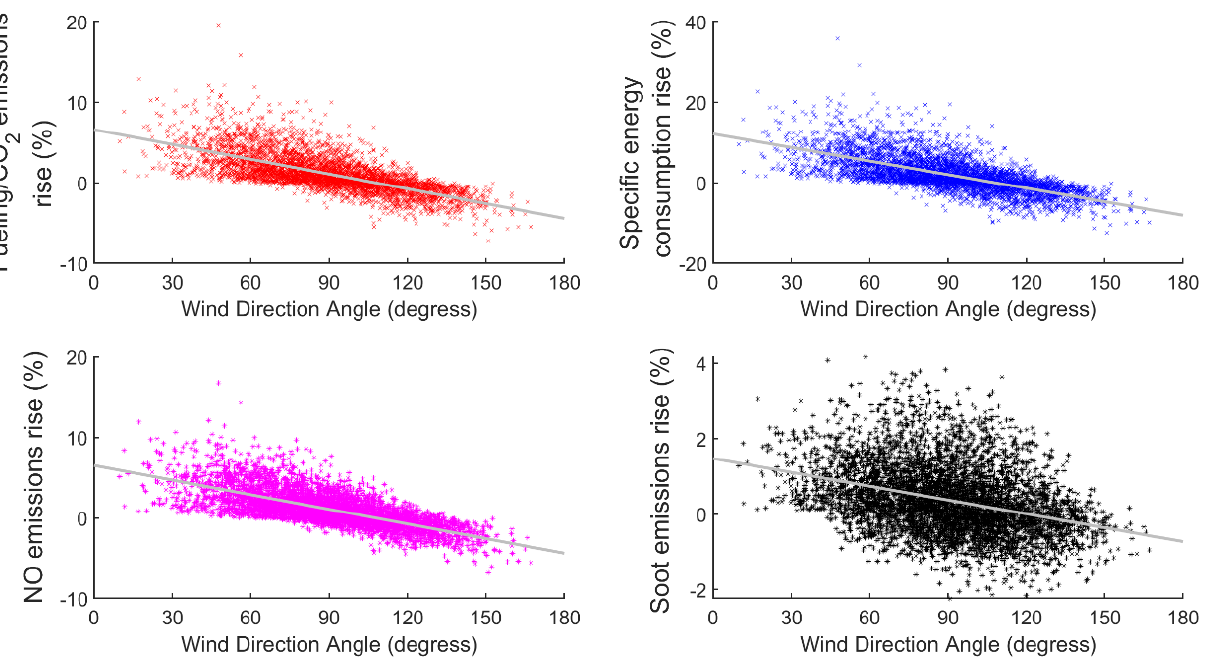
Figure 12. Percentage increase in fuel/energy consumption and emissions vs. mean wind direction for the high phase of the WLTC.